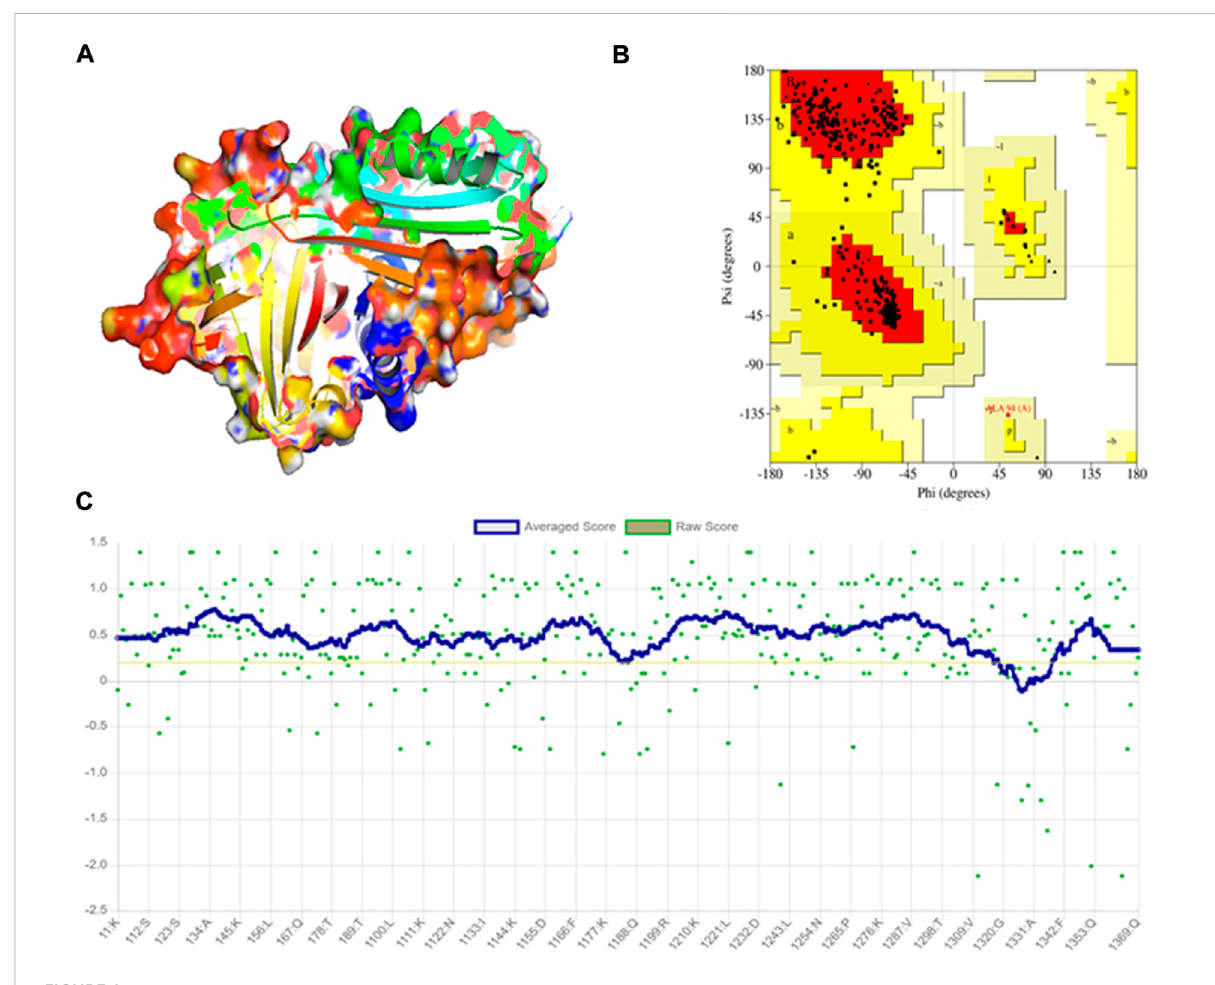
FIGURE 1 Modeling and stereochemical quality analysis of A1AT wildtype protein. (A) Energy-minimized wildtype model of A1AT protein generated by Pymol2. (B) Ramachandran Plot for the A1AT energy-minimized wildtype structure representing amino acid deposits in the center and non-center areas of the protein (90.9% – 8.8%, respectively). (C) Hydrogen bonding estimation of energy-minimized A1AT wildtype protein, indicating a good quality